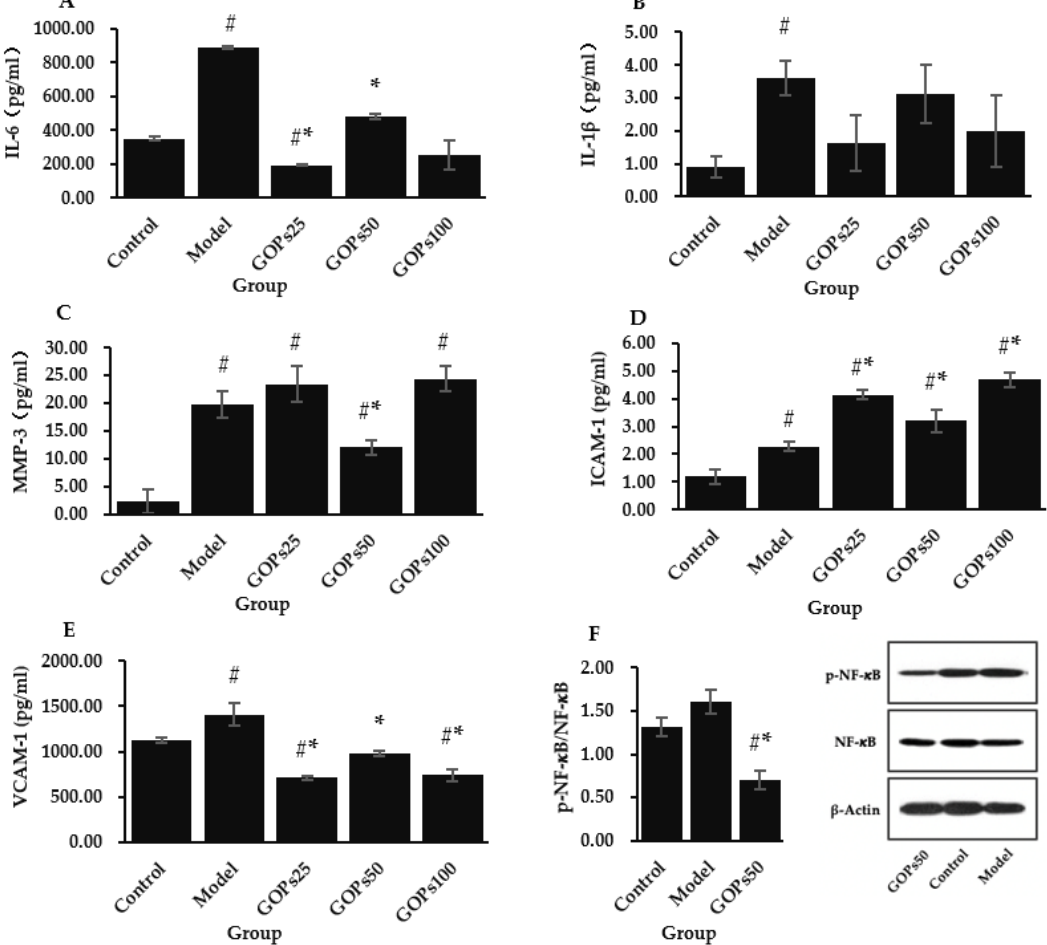
Figure 3. Effect of GOPs on the senescence-associated secretory phenotype (SASP). ( A ) Effect of GOPs on the interleukin-6 (IL-6) concentration. ( B ) Effect of GOPs on the IL-1 β concentration. ( C ) Effect of GOPs on the matrix metalloproteinase-3 (MMP-3) concentration. ( D ) Effect of GOPs on the intercellular cell adhesion molecule-1 (ICAM-1) concentration. ( E ) Effect of GOPs on the vascular cell adhesion molecule-1 (VCAM-1) concentration. ( F ) Effect of GOPs on the activation of p-NF- κ B/NF- κ B. Values represent the mean ± S.D. ( n = 3 per group). # p < 0.05 versus control group, * p < 0.05 versus model